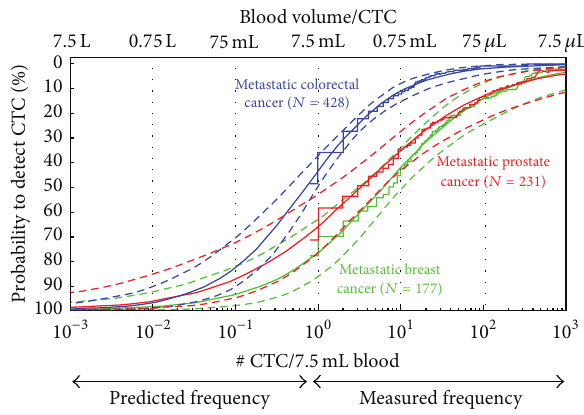
Figure 3: Frequency of CTC in metastatic colorectal prostate and breast cancer. Frequency was measured in 7.5mL of blood (right half of the figure) and predicted in larger blood volumes (left half of the figure). Extrapolation of number of CTC was performed by a log-logistic function (solid line) including 95% confidence interval (dashed lines) and fitted through the empirical cumulative distribution functions (stair plots) for metastatic breast, colon, and prostate cancer. The fitted curve shows the blood volume that is needed (7.5 L) to detect the presence of CTC in all patients (100% probability) in a metastatic setting, using the CellSearch approach. Adapted figure from